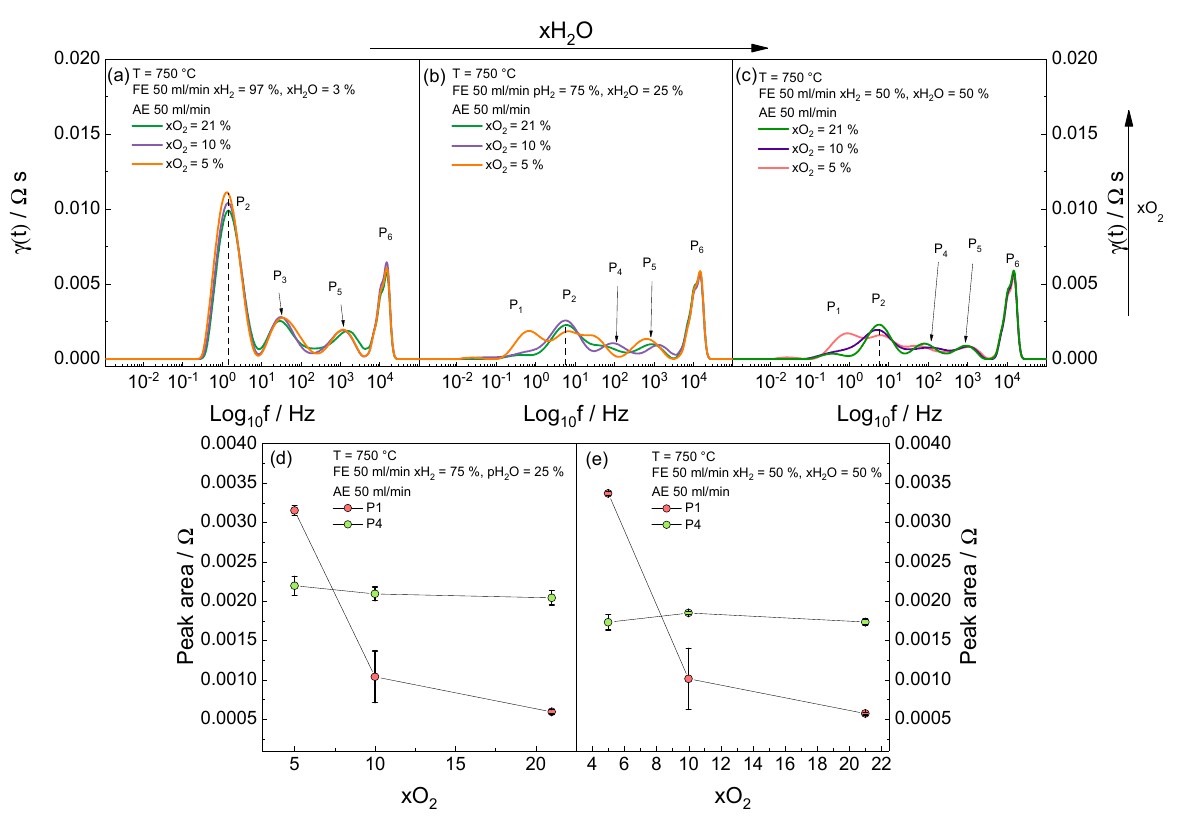
Figure 7. DRT functions obtained at ( a ) xH 2 O = 3%, ( b ) xH 2 O = 25%, and ( c ) xH 2 O = 50%. P1 and P4 area vs. xO 2 at ( d ) xH 2 O = 25% and ( e ) xH 2 O = 50% in the fuel. T = 750 °C, Q FE = 50 mL min − 1 , and Q AE = 50 mL min − 1 . Green line xO 2 = 21%, purple line xO 2 = 10%, and orange line xO 2 = 5%.